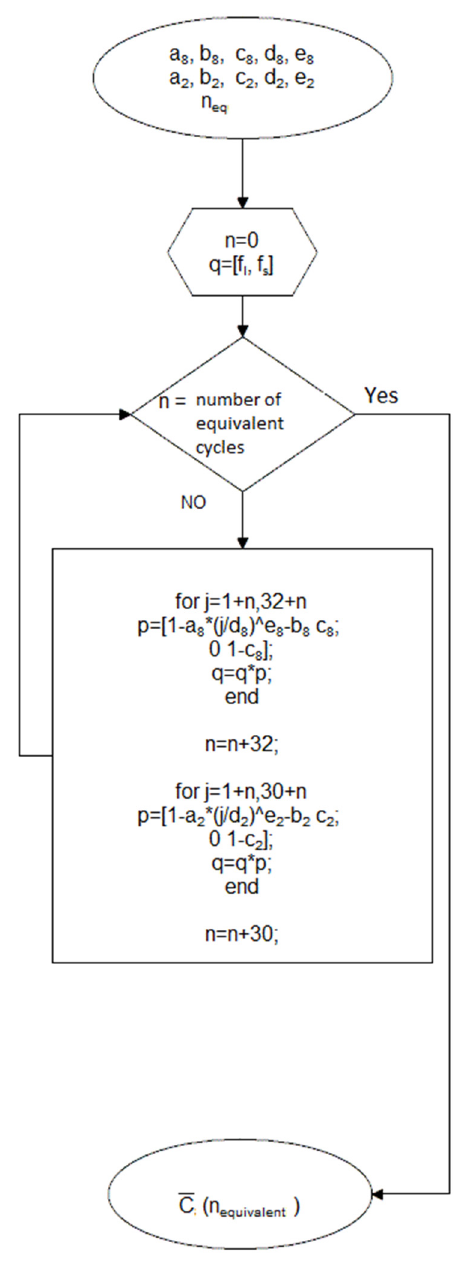
Figure 10. Flowchart of the life span extrapolation method, based on transition matrix Figure 10 . Flowchart of the life span extrapolation method, based on transition matrix (8).